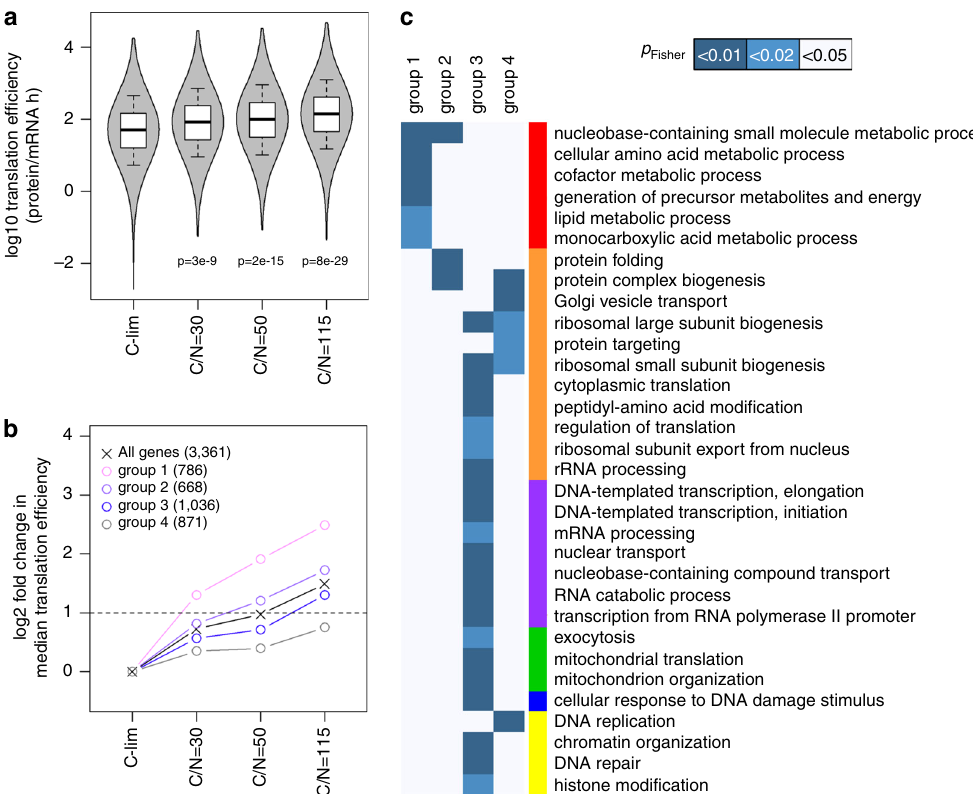
Fig. 4 Reserves of translational capacity are preferentially used to translate metabolic proteins. a Gene-speci fi c translation ef fi ciency was calculated in all growth conditions. The p -values indicated are from two-sided Student ’ s t -tests. Center line, median; box limits, upper and lower quartiles; whiskers, 1.5× interquartile range. b Genes were grouped based on the step of nitrogen reduction at which their translation ef fi ciency was increased by log2 > 1. Data points re fl ect the median translation ef fi ciency of each group, with the # of genes belonging to each group shown in parentheses. Horizontal dashed line indicates twofold increase from C-limited cultures. c Enrichment of GO-slim terms in each gene group as de fi ned in b was analyzed by two-sided Fisher ’ s exact test. GO-slim terms are color-coded by functional category as in Fig. 1b. GO-slim terms with FDR-adjusted p Fisher < 0.05 in at least one gene group are